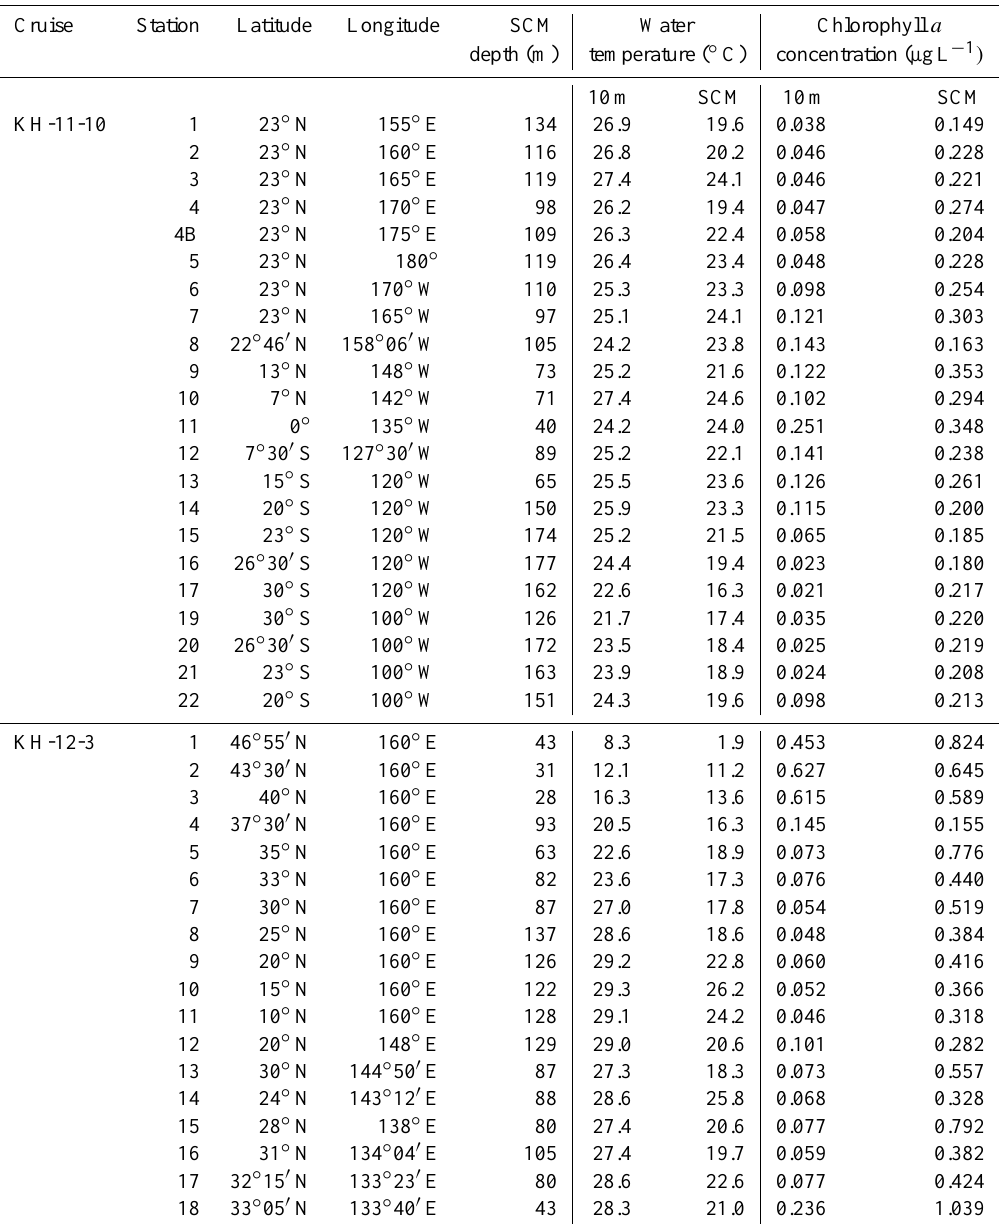
Table 1. List of sampling